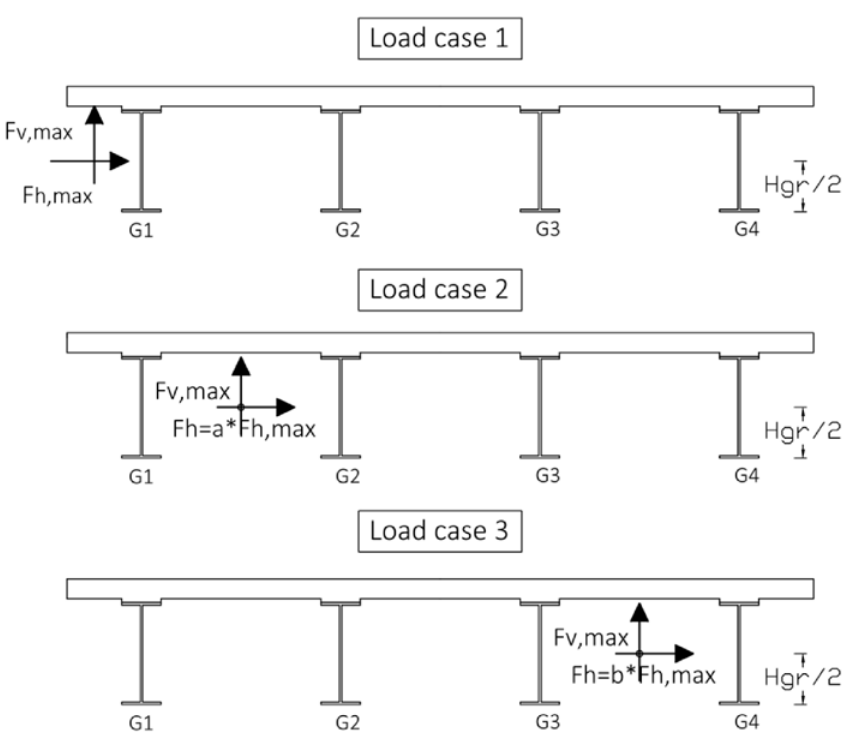
Figure 23. Load cases for the improved physics-based simplified method.